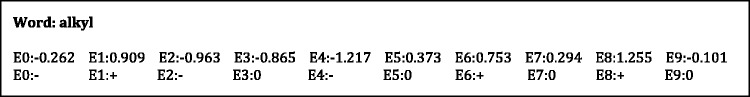
A comparison between real-valued and binarized embedding features.